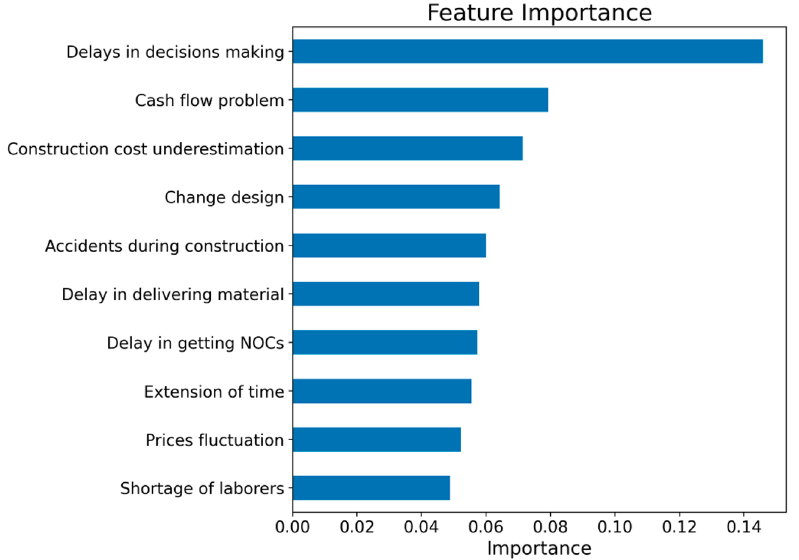
Figure 5. Feature importance (top-10 out of 19) based on the random forest model with the SFM feature optimiser.